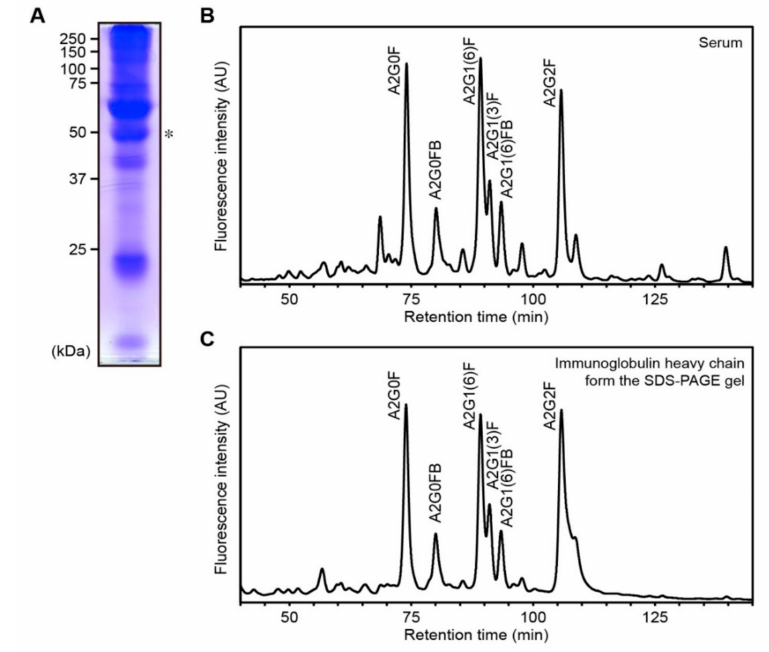
Figure 3. A2G1(6)FB is harbored on the Ig heavy chain. ( A ) Coomassie Brilliant Blue (CBB) staining of acetone-precipitated serum sample (healthy control). * The band (asterisk) was excised and subjected to N -glycan analysis. ( B ) NP-HPLC chromatogram of neutral N -glycans in healthy control serum. ( C ) NP-HPLC chromatogram of neutral N -glycans from the gel piece in Figure 3A. The band mainly contained Ig heavy